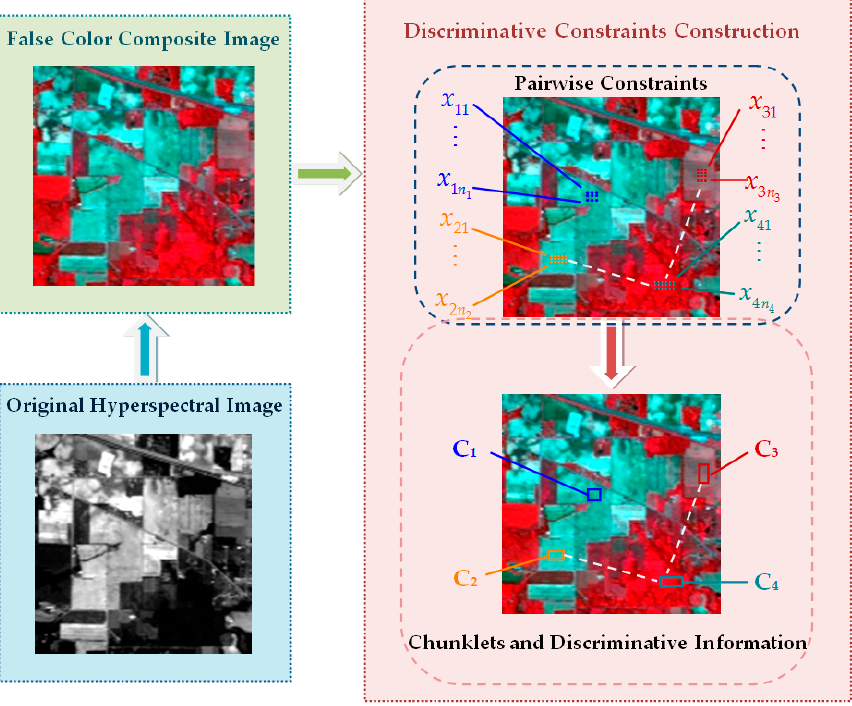
Figure 1. Example of the process of the construction of the discriminative constraints.